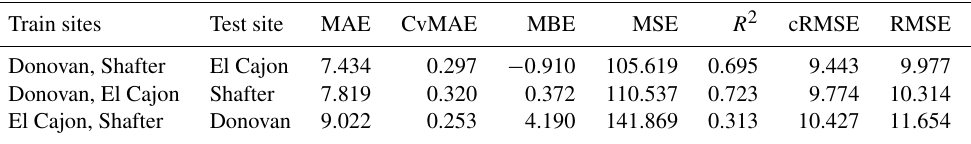
Table D8. Test results for split-NN Level 2, size 9 (O 3